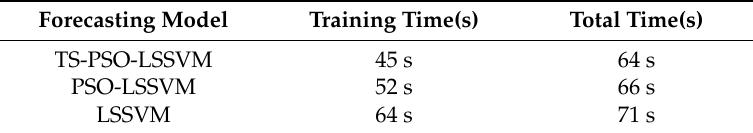
Table 7. Training times of the three forecasting